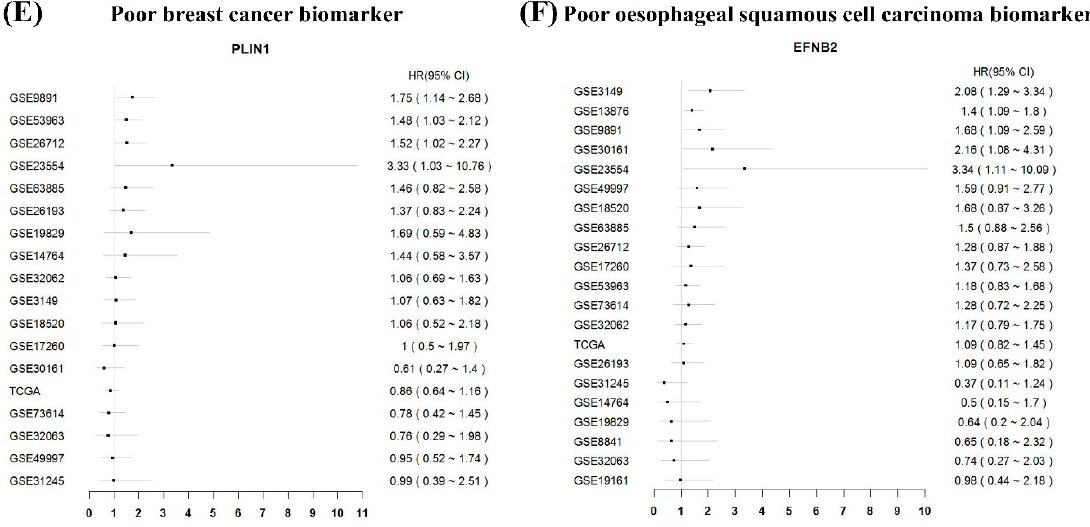
Figure 4. Excavation of potential prognostic biomarkers for ovarian cancer by OSov utilizing other tumor prognostic biomarkers. ( A ) TUBB6 gene in OSov (colon cancer biomarker); ( B ) SFRP4 gene in OSov (pancreatic cancer biomarker); ( C ) NUAK1 gene in OSov (hepatocellular carcinoma biomarker); ( D ) MFAP2 gene in OSov (gastric cancer biomarker); ( E ) PLIN1 gene in OSov (breast cancer); ( F ) EFNB2 gene in (oesophageal squamous cell carcinoma). TUBB6: Tubulin beta-6 chain; SFRP4: Secreted frizzled-related protein 4; NUAK1: NUAK family SNF1-like kinase 1; MFAP2: Microfibrillar-associated protein 2; PLIN1: Perilipin-1; EFNB2: Ephrin-B2. Cutoff: upper 25% vs. other